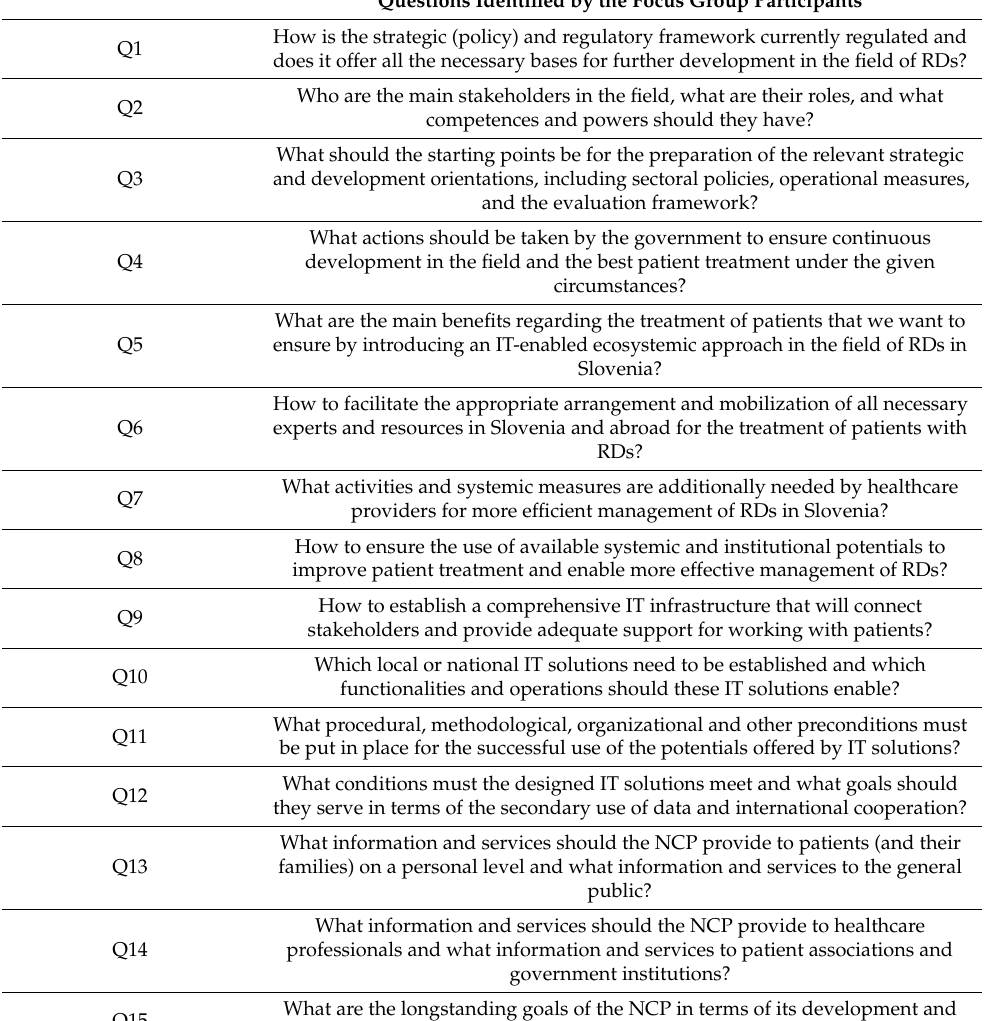
Table 3. The baseline questions to be addressed by the ecosystemic